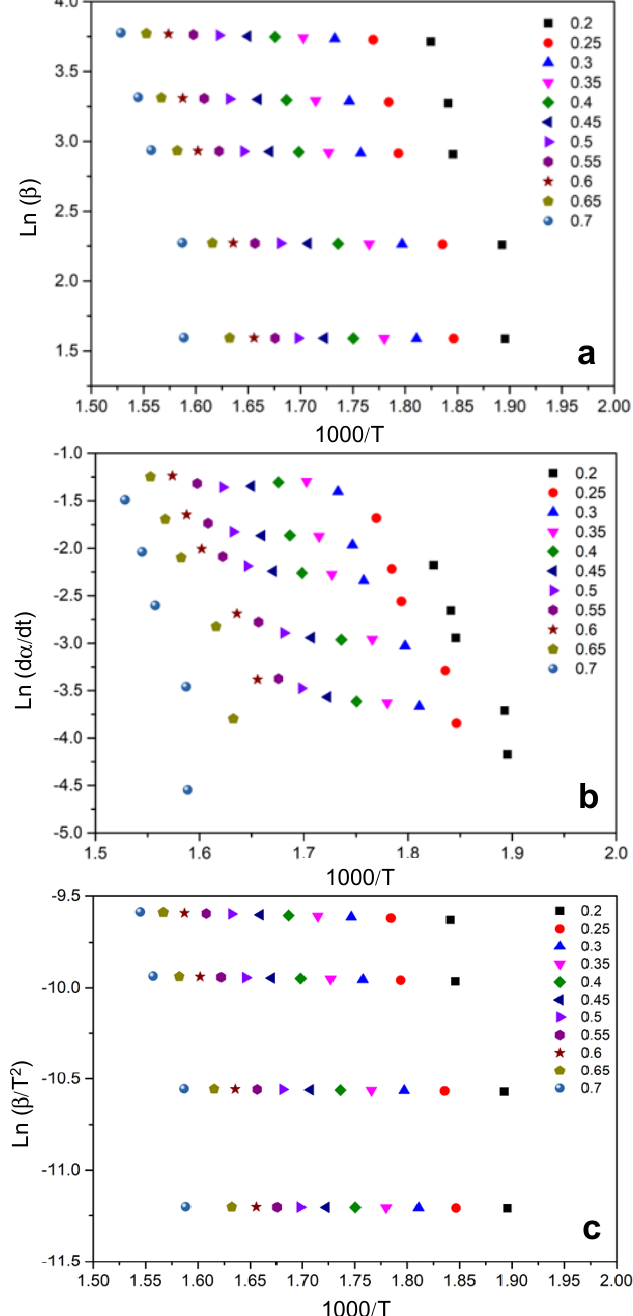
Figure 4. The conversional fractions for ( a ) FWO, ( b ) KAS and ( c ) Friedman methods for chicken manure derived at various heating rates. Table 4. The activation energy for chicken manure derived from FWO, KAS and Friedman methods.